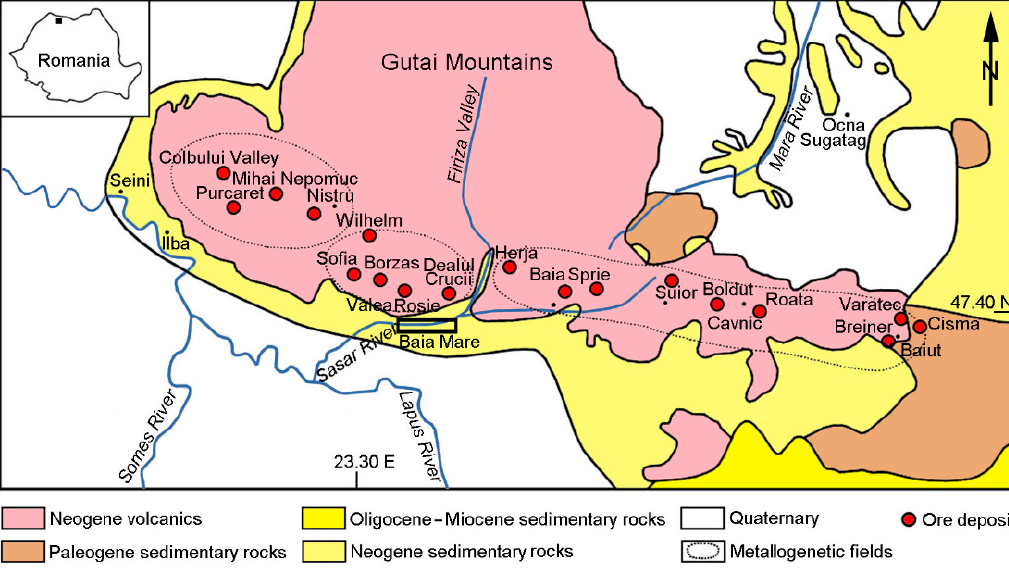
Figure 2. Simplified geology of the Baia Mare ore district, NW Romania with location of main ore deposits including Herja (modified after [4]).